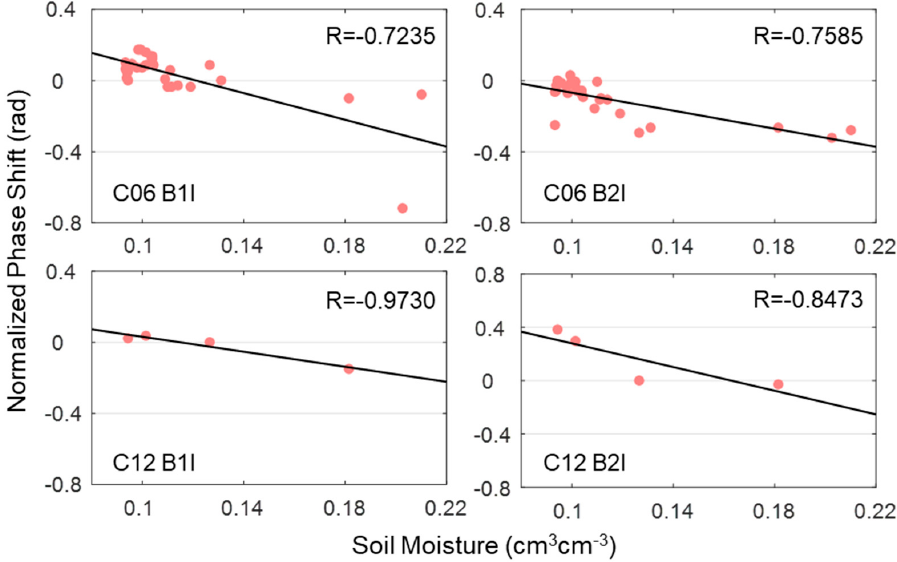
Figure 7. Correlations between the normalized phase shift sequences and soil moisture for BDS IGSO (C06) and MEO (C12) satellites on B1I and B2I frequencies.